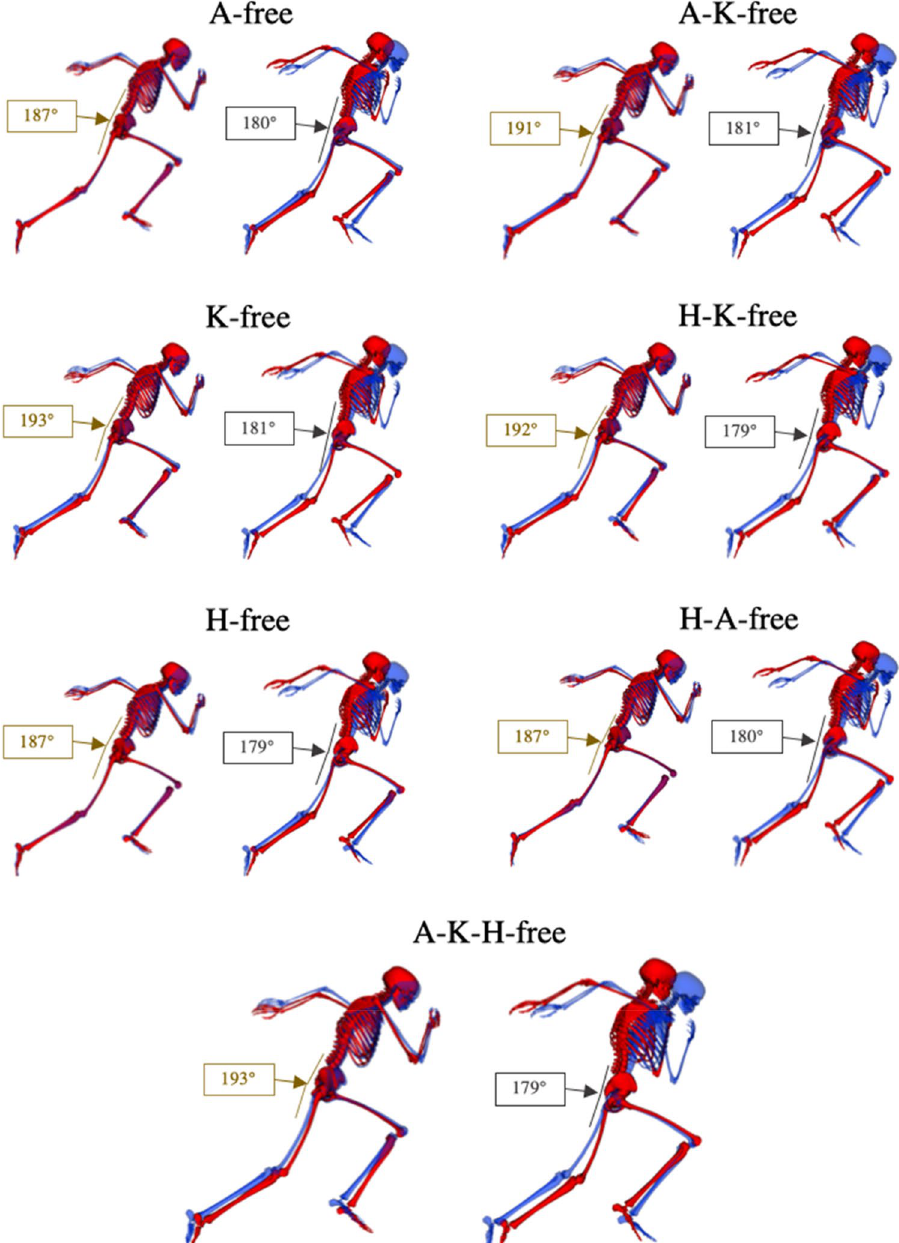
Figure 7. Right and left foot take-off configurations for the data-tracking (blue model) and predictive simulations (red model). The angles included are between the trunk and thigh segments for the predictive simulations, with angles greater than 180° reflecting front-side mechanics. Images generated using OpenSim 3.3 software (https:// opens im. stanf ord.